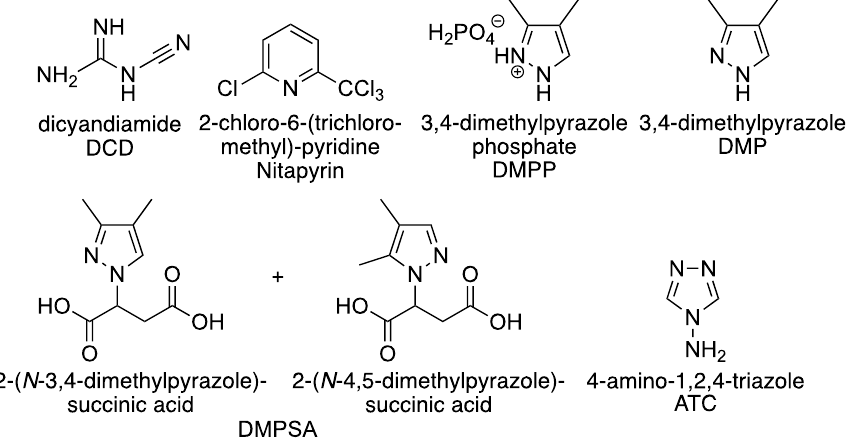
Figure 1. Selected N-containing nitrification inhibitors.